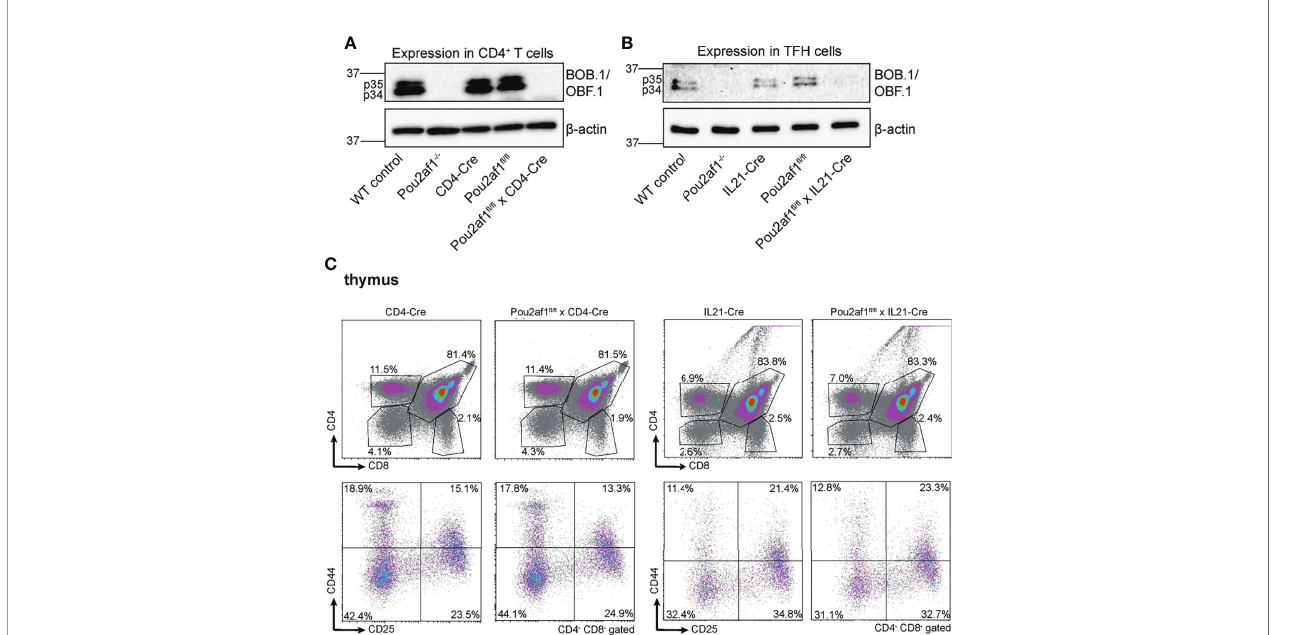
FIGURE 1 | Conditional deletion of Pou2af1 in CD4 + T cells as well as TFH cells. (A, B) p34 and p35 BOB.1/OBF.1 isoform protein levels in CD4 + T (A) and TFH (B) cells were determined by immunoblotting, respectively. b -actin was used as loading control. (C) Representative fl ow cytometry plots of T cell development in the thymus of respective Cre-controls and conditional knockouts are shown. Gating strategy is shown in Figure S7